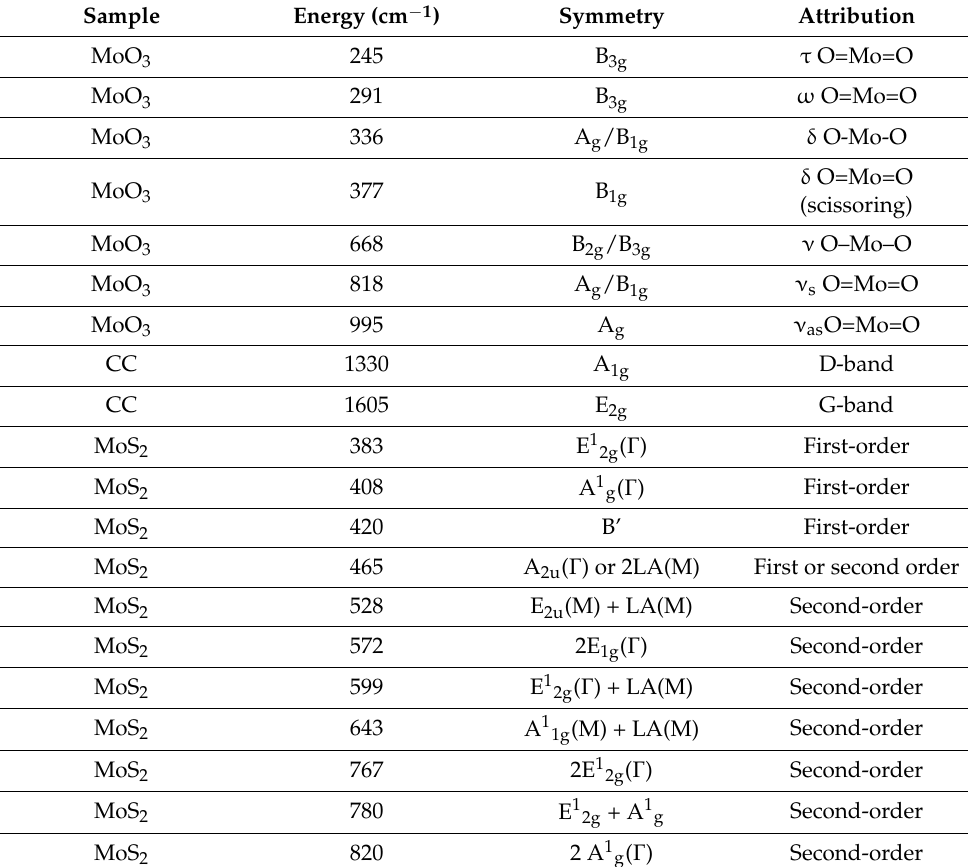
Table 1. Peaks frequency, group theory representation and attribution of the modes observed in the Raman spectra of the different samples